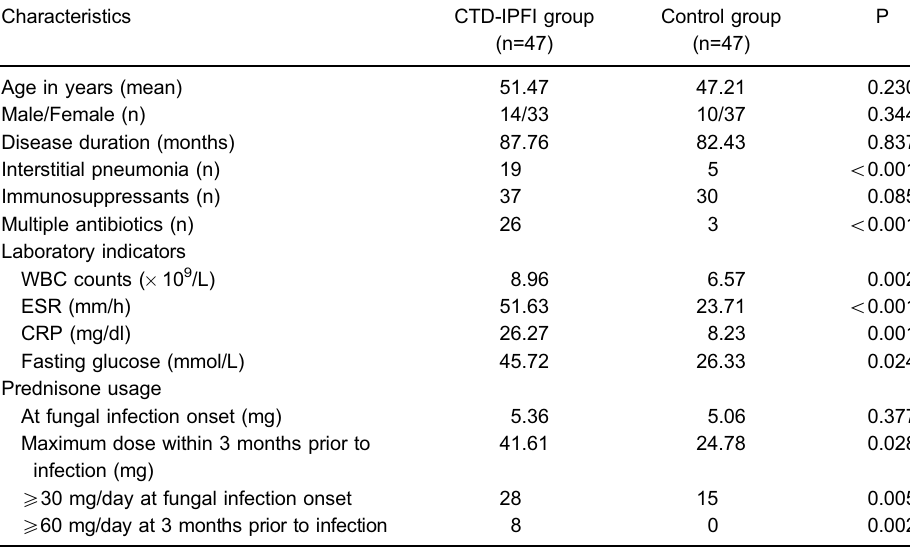
Table 1. Demographic and clinical characteristics of patients with connective tissue disease associated with invasive pulmonary fungal infection (CTD-IPFI) and patients with CTD only (control group).